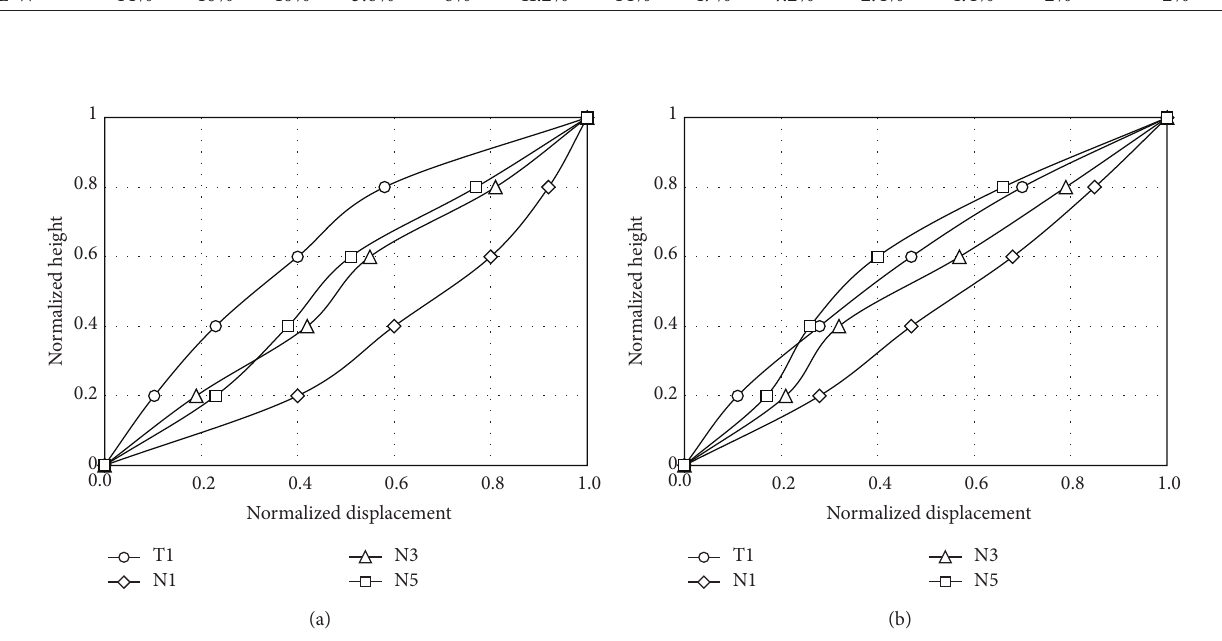
Figure 11: Mode shapes of the building: (a) N-S direction, (b) E-W